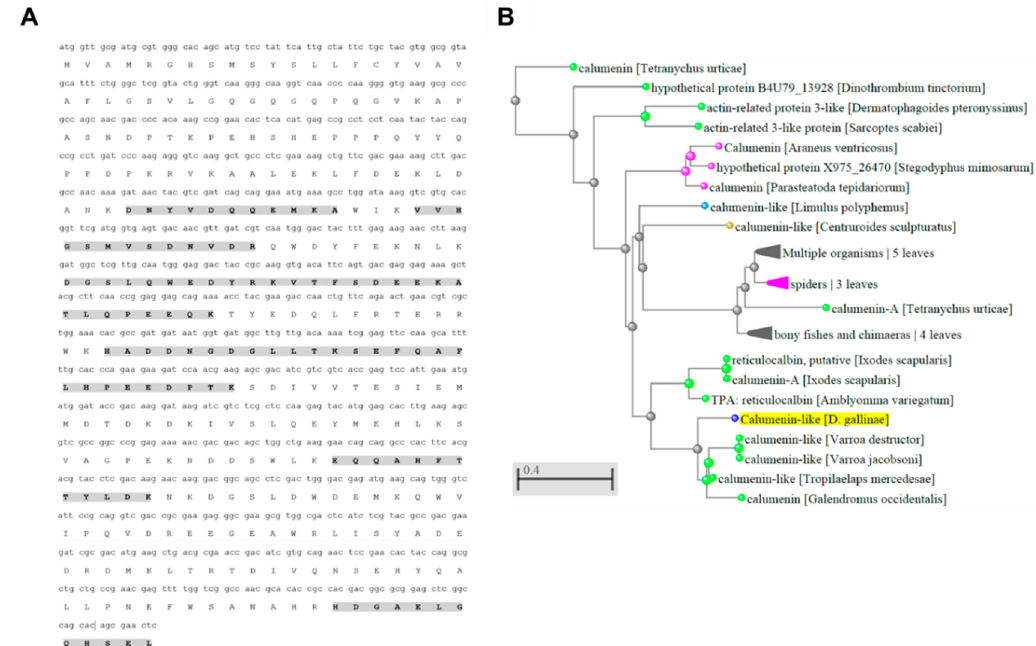
Figure 6. Deg-CALU protein coverage and phylogenetic analysis. ( A ) Calumenin isoform 2 coding sequence (isotig18930) [26]. Translated amino acid is shown with its corresponding nucleotide triplet. Peptides identified by RP-LC-MS/MS are marked (grey shadow). ( B ) Phylogenetic tree for Deg-CALU was constructed using the Blastp tool from BLAST (https://blast.ncbi.nlm.nih.gov/Blast.cgi).